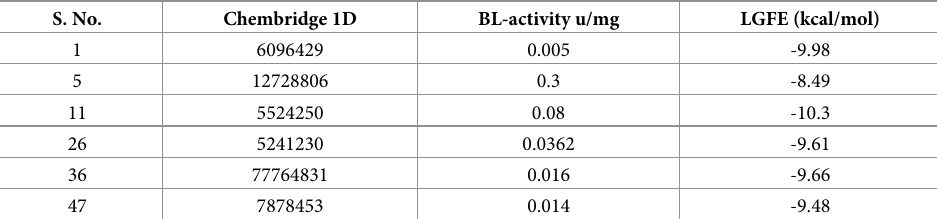
Table 1. BL-activity and LGFE scores of lead compounds identified as inhibitors.